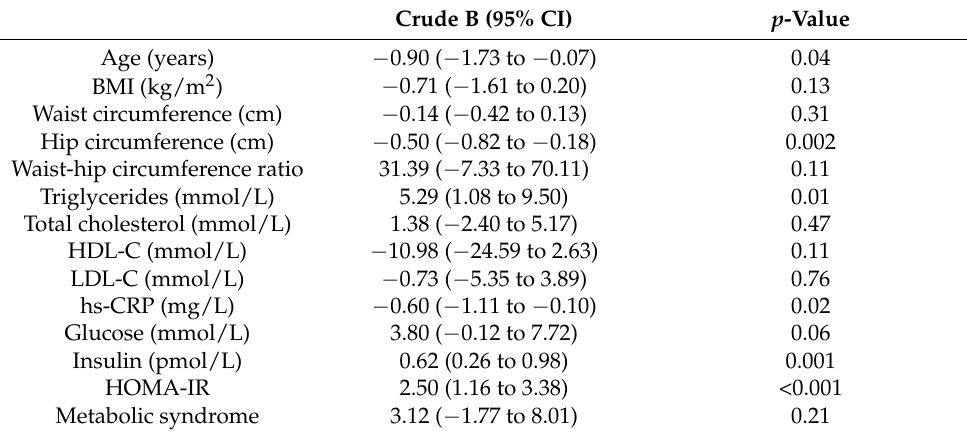
Table 3. Associations between serum FT ( µ M) and cardiometabolic outcomes regardless of random- ization group or time